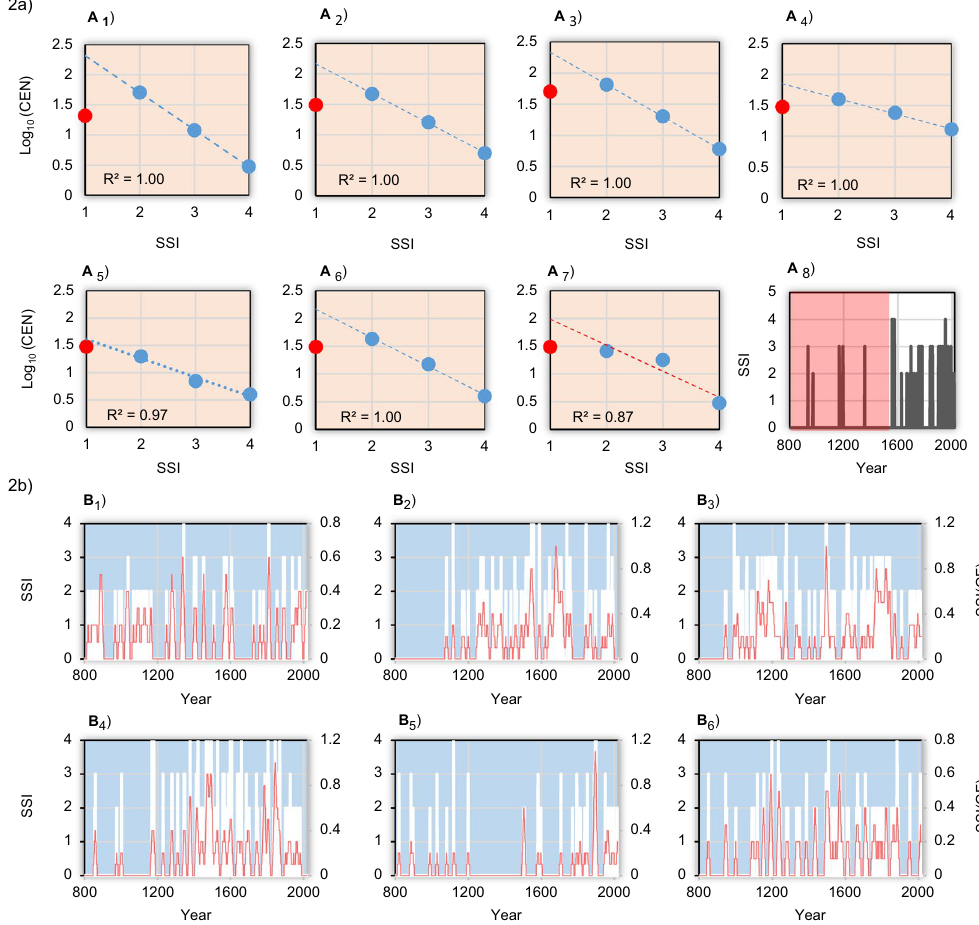
Figure 2. Cumulative distribution of the logarithm of number of storm events versus their storm severity index (SSI) and relative time-series during the period 800–2017 in Italy. (Panel a) A 1 Marche region, A 1 Arno river basin, A 2 Hot-Spots, A 3 Tiber basin, A 4 Calore basin, A 5 Adige basin, and A 6 Calabrian-Sicily regions. In A 7 note that for this last area, the catalogue result not complete (data points are not aligned along the linear regression), and this was due to shortage of information during the period 1200–1500 (pink area of the SSI-time series. Red points in the scatterplots represent the storm event with SSI = 1. (Panel b) As in a, but for time-series of SSI,